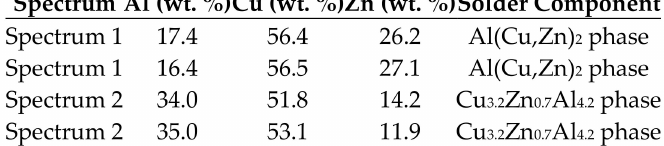
Figure 16. The point EDX analysis of the Cu/Zn5Al3Cu boundary.